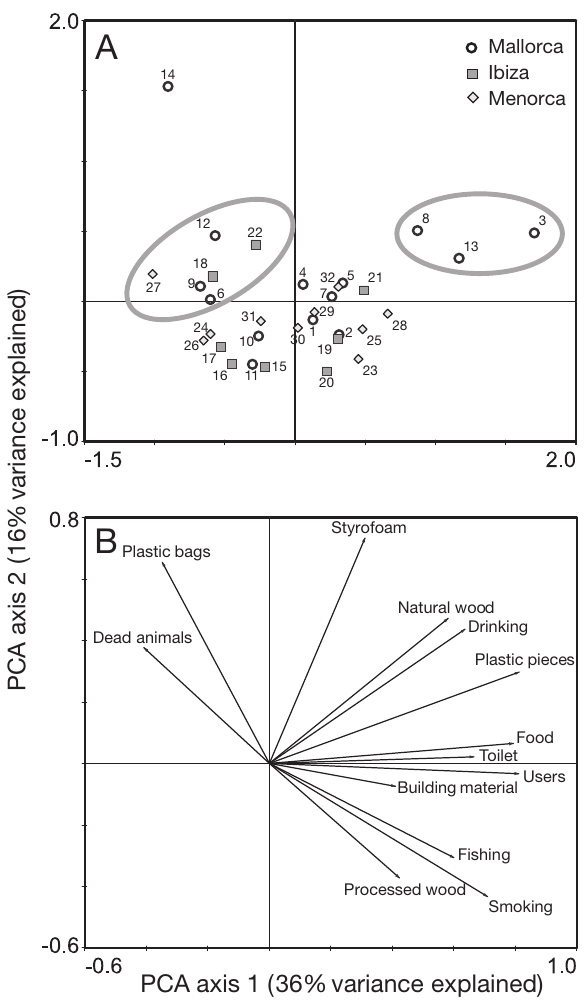
F IG . 6. – A, plot of the principal component analysis of survey sites using group classification of Table 3; B, plot of the variables corre- sponding to the analysis in Figure 6A. Small angles between arrows indicate positive high correlations between